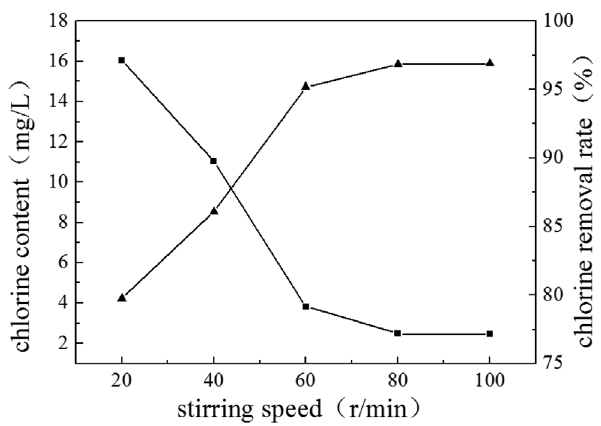
Fig. 8: Effect of stirring speed on chlorine content and Cl removal rate